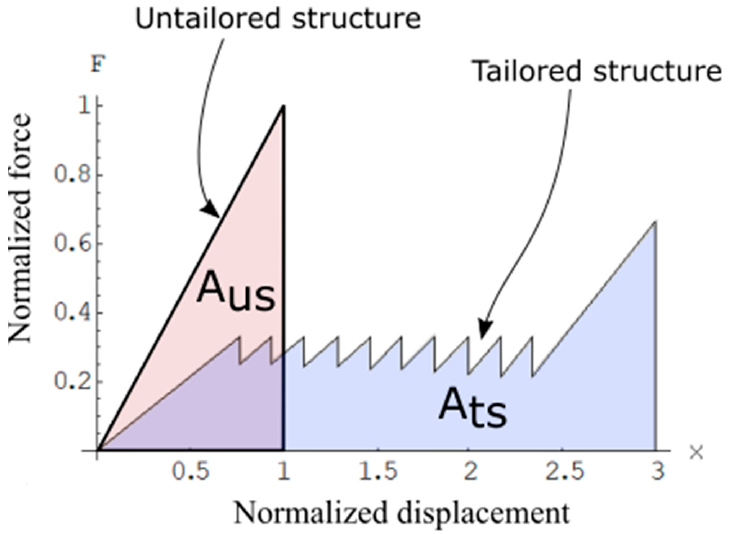
Figure 3. Comparison of response prediction.